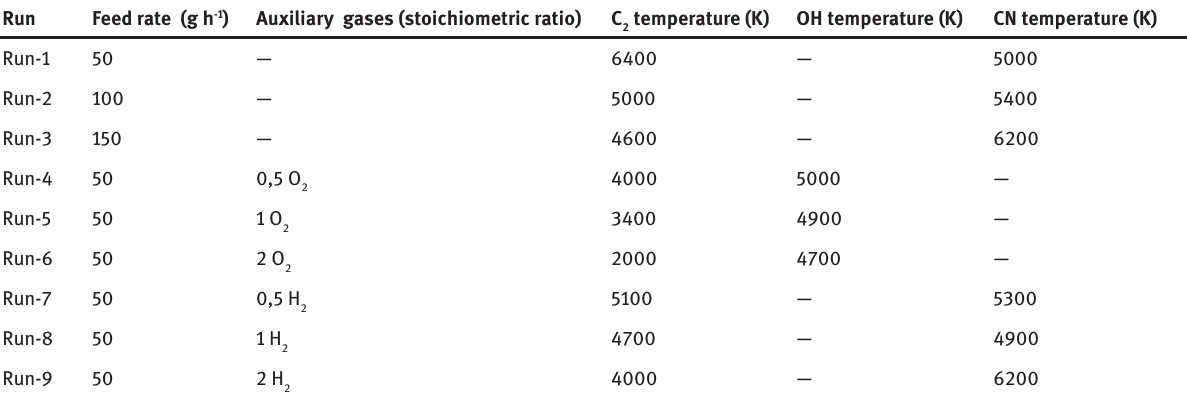
Table 1 : Tests conditions.